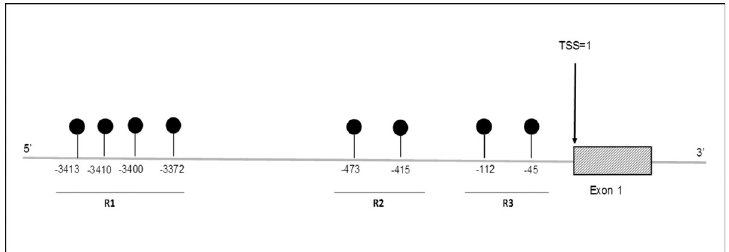
Fig 2. Schematic illustration of the location of the eight CpG sites upstream of the ADIPOQ gene. Region 1 (R1) represents 4 CpGs at -3413, -3410, -3400 and -3372, R2 represents 2 CpGs at -473 and -415 and R3 represents 2 CpGs at -112 and -45. TSS: Transcription start